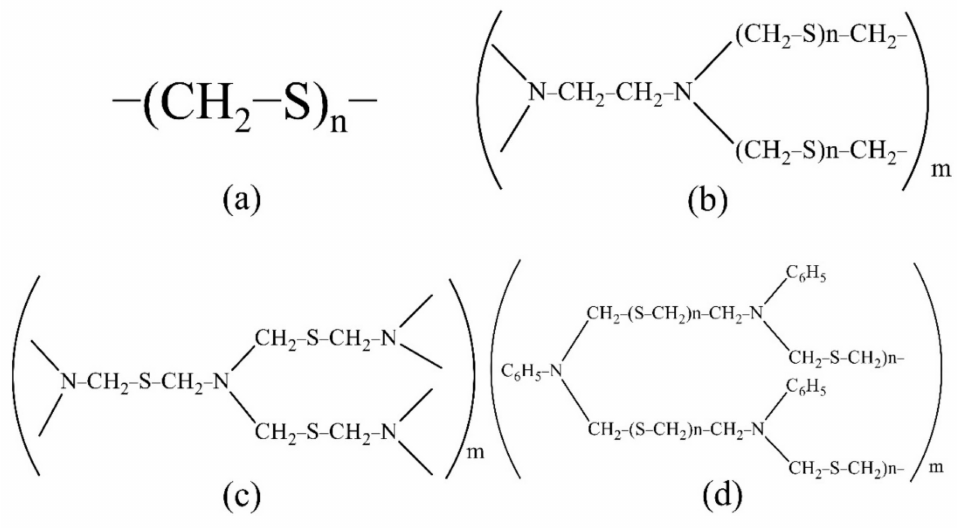
Figure 1. The structure of the sorbents studied (( a ): PTE, ( b ): PED, ( c ): TDA, ( d ): PhED). To increase the sorption efficiency of the sorbent, aqueous ammonia (Himmed, Russia), ethylenediaminetetraacetic acid (EDTA) (ACS reagent, Merck, Germany), salicylic acid (ACS reagent, Merck, Germany), acetamidine (ReagentPlus, Merck, Germany), methy- lamine (ReagentPlus, Merck, Germany), hydroxylamine (ReagentPlus, Merck, Germany), trimethylamine (ReagentPlus, Merck, Germany) and dithiothreitol (ReagentPlus, Merck, Germany) were